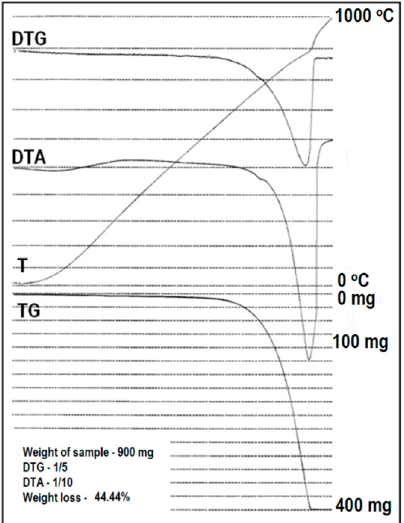
Figure 6. Derivatogram of sample SO14, limestone of the Karchowice Unit taken in the Strzelce Opolskie Quarry [21].